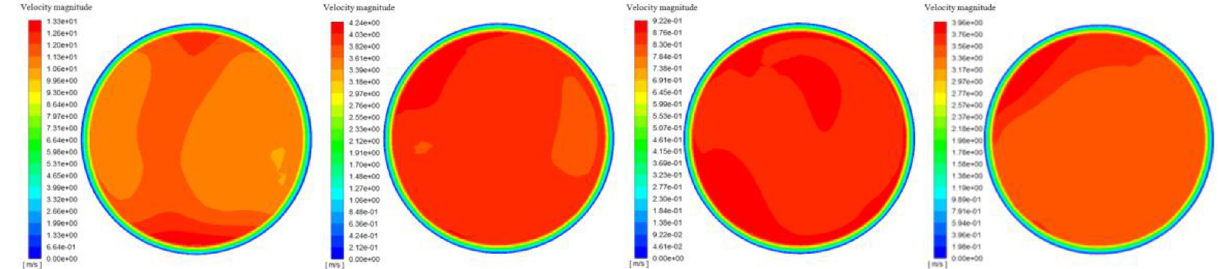
Fig. 10. Contours of velocity with Pre-SCR.